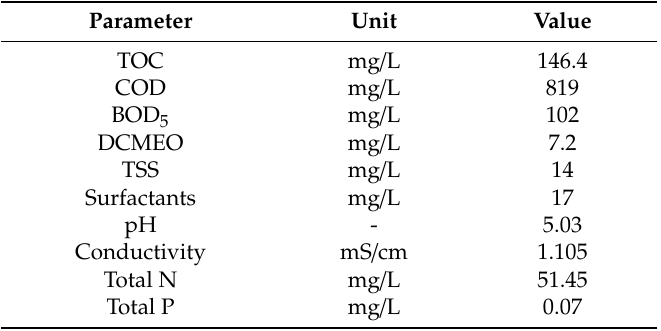
Table 1. Parameters of wastewater pretreated in the cosmetic factory by aluminum-based coagulants coupled with dissolved air flotation (C /